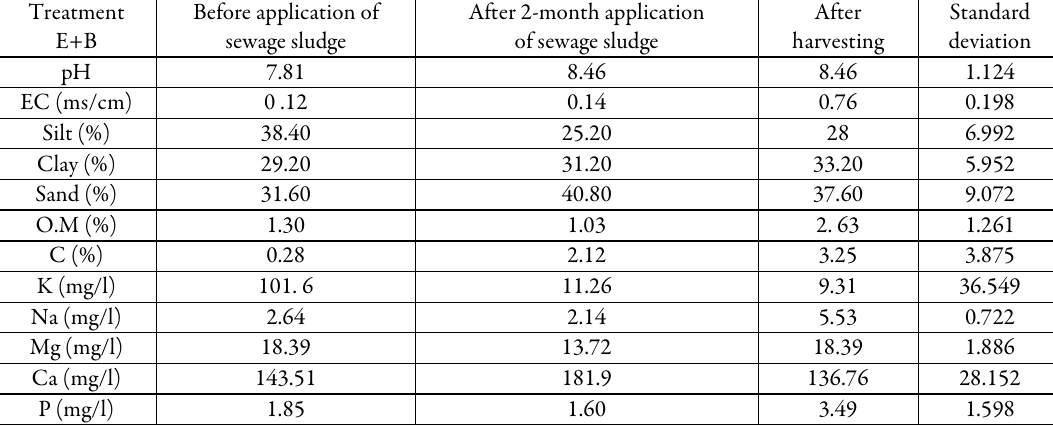
Table 7. Mean values of physicochemical parameters of soil with sewage sludge and fertilizer before application of sewage sludge and after